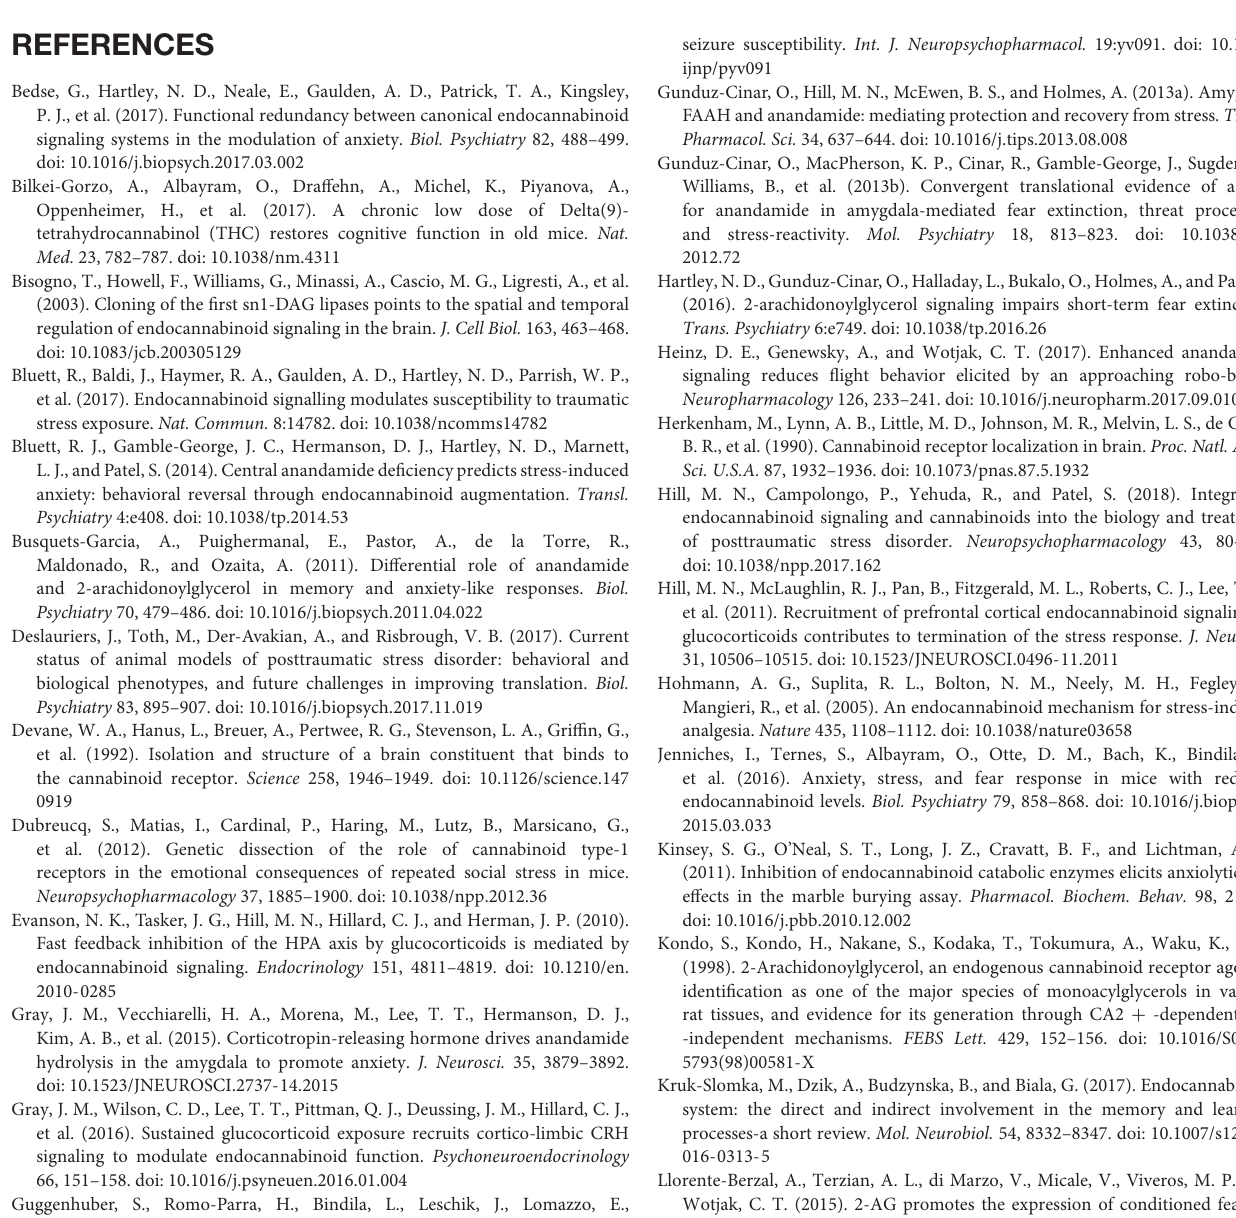
FIGURE S1 | DO34 treatment prior to extinction training mimics the effect of no fear extinction training. (A) Schematic diagram of the experimental paradigm. (B) (Far left panel) % freezing by C57BL/6J male mice during conditioning assay (Middle panels) % freezing during auditory cue during extinction training days 2 and 3. “No extinction” group remained in home cage during extinction trials day 2–3. (Far right panel) % freezing during extinction recall ( n = 15 male mice per condition). F - and P -values and η 2 for main effect of condition (extinction versus no extinction) shown in relevant panels. All values are presented as mean ± SEM. FIGURE S2 | THC does not reverse impaired extinction after DAGL inhibition. (A) Schematic diagram of the experimental paradigm. (B) (Far left panel) % freezing by C57BL/6J male mice during acquisition of cue-conditioned fear. (Middle panels) % freezing during auditory cue by mice during extinction training days 2 and 3 when DO34 (50 mg kg − 1 ) was injected IP 2 h prior to trial, alone or